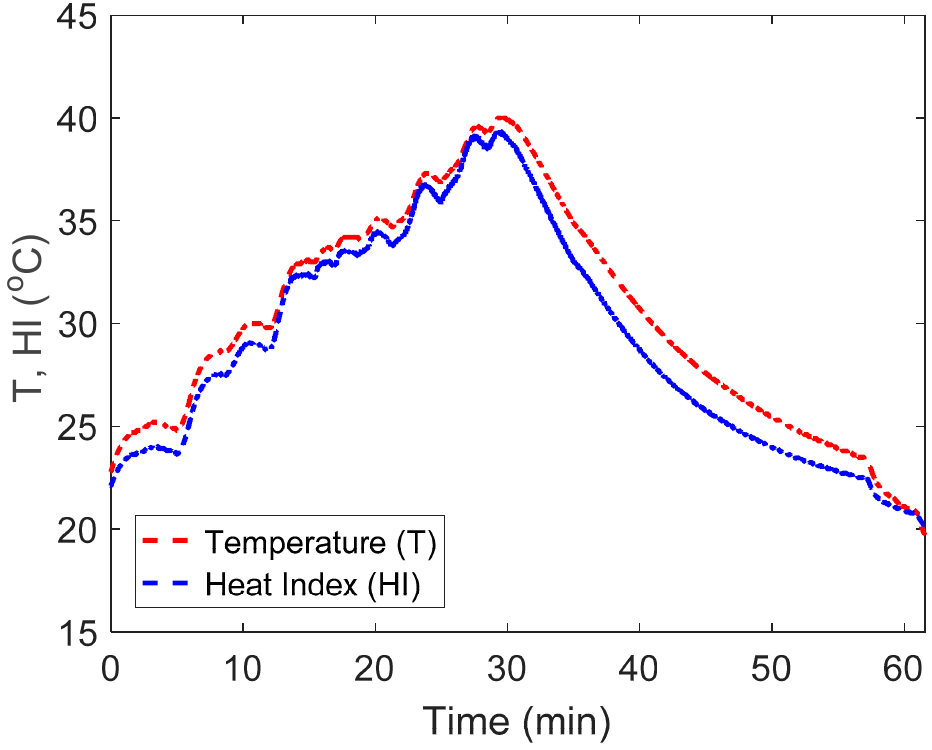
Figure 5. Comparison of heat index (HI) and measured temperature (T), both reported as °C, where the red line represents the measured temperature values and the blue line is HI calculated using relative humidity (RH) and the temperature from within the slot in the foam cushion.